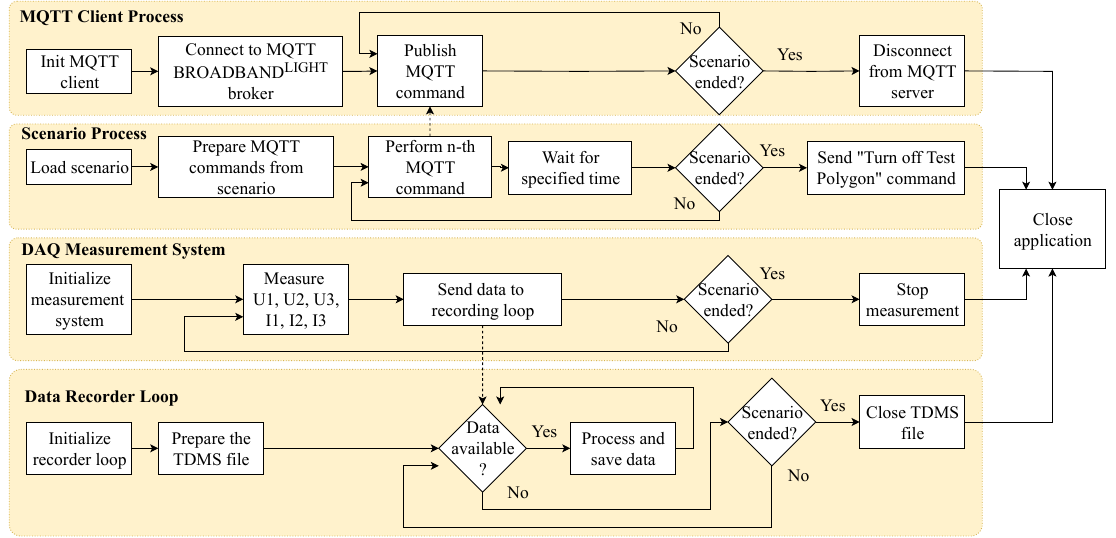
Figure 12. Algorithm for experiment